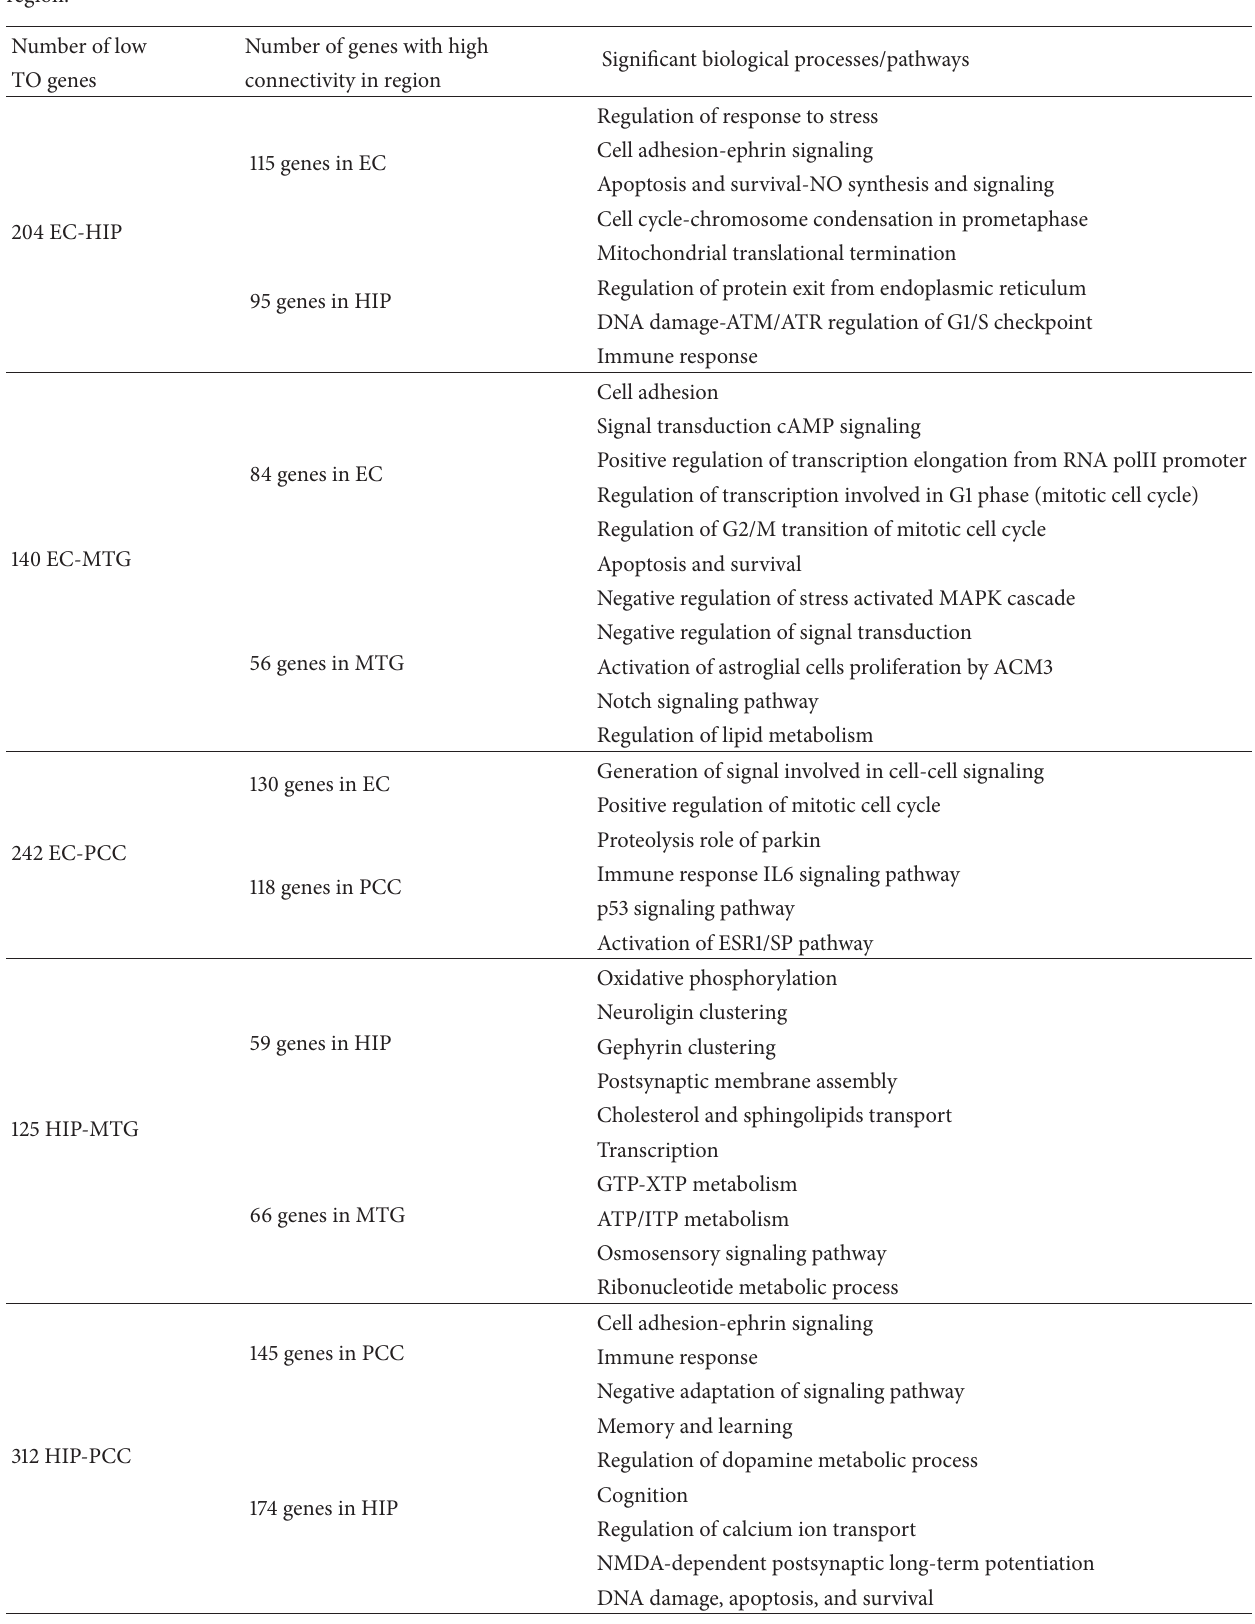
Table 3: Significant biological processes of the low TO genes that have a larger number of links in the coexpression network of a particular